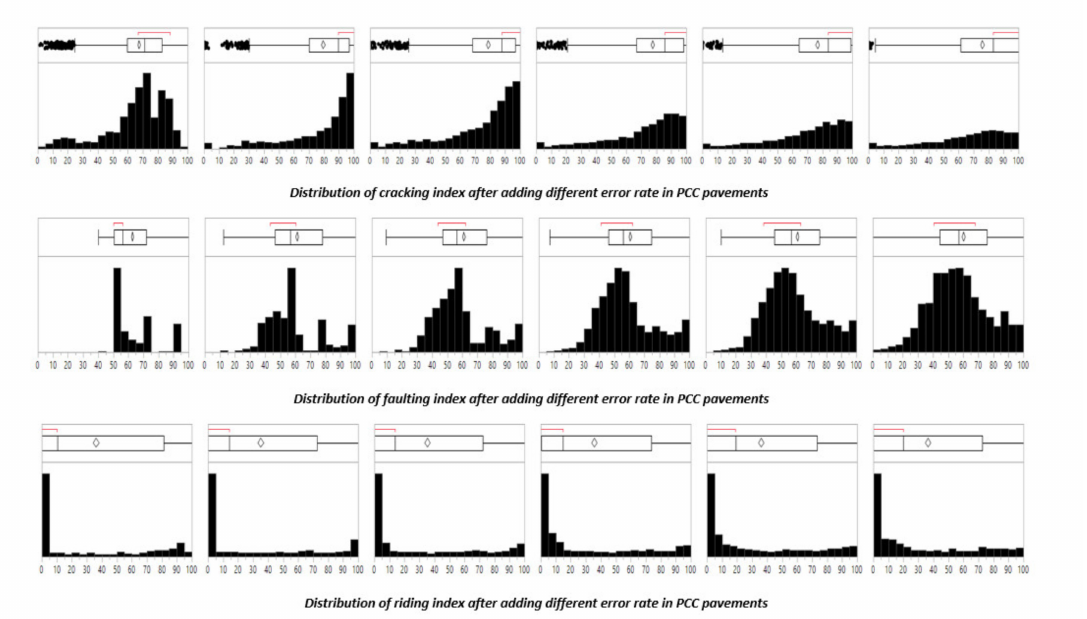
Figure 4. Distribution of individual indexes in PCC pavement type after applying the different rate of errors (base scenario, 10%, 30%, 50%, 70%, and 90% rate of error, left to